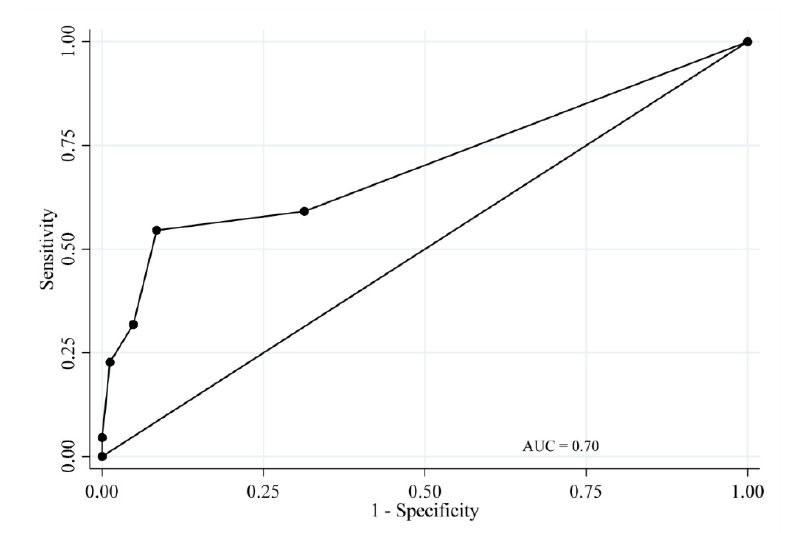
Figure 3. Receiver operating characteristic curve for the TLP-AA-Kit score for moderate / severe periodontitis.